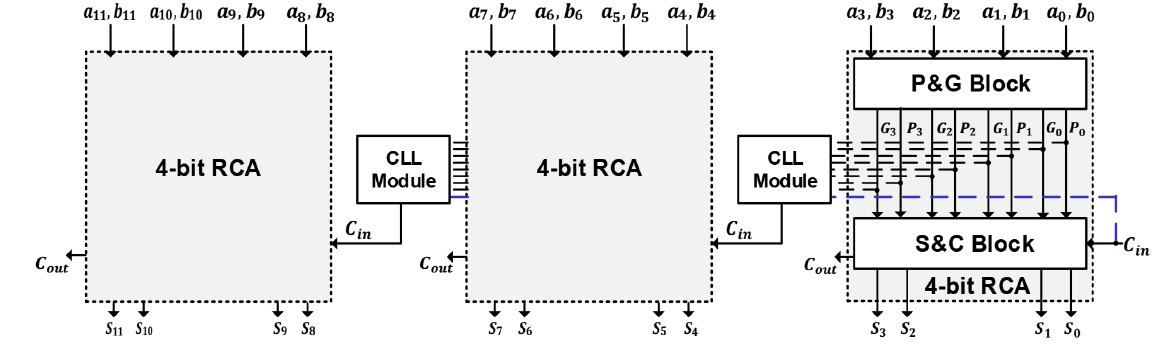
Figure 1. Block diagram of PRCA.